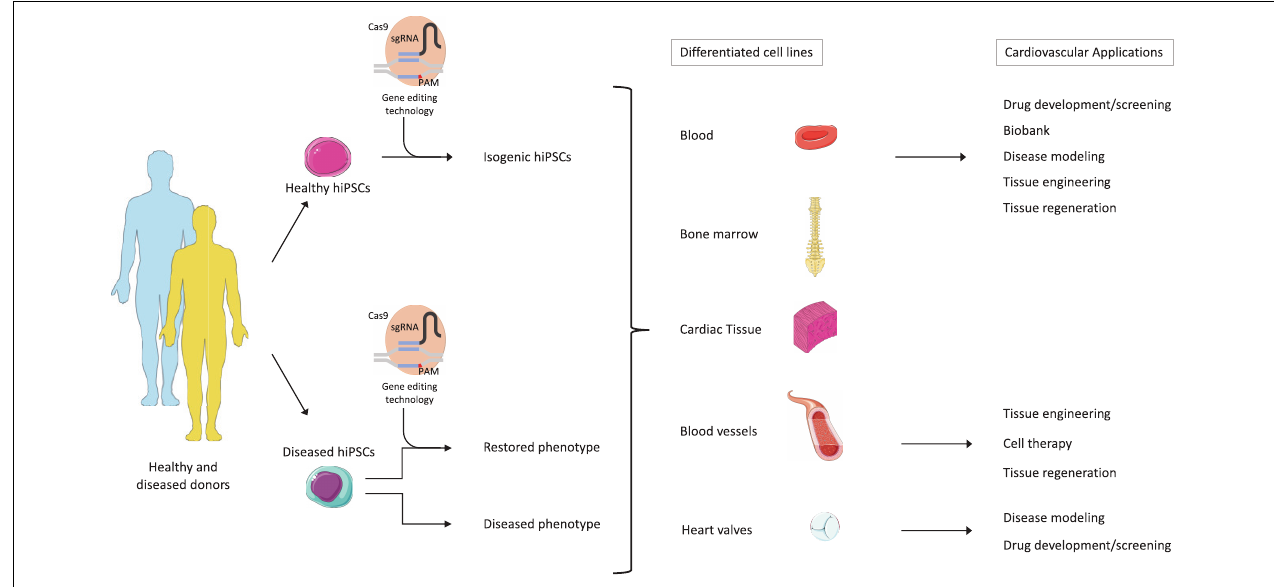
FIGURE 3 | Therapeutic potential of hiPSC technology combined to gene editing and tissue engineering. The figure describes the potential applications of hiPSCs and gene editing. First, hiPSCs would be generated from the reprogramming of patient-specific healthy or diseased somatic cells. Second, gene editing tools, such as CRISPR-Cas9, would then generate isogenic cell lines harboring specific genetic mutations in the healthy hiPSCs, but also correct disease-causing mutations in the patient populations. The generated hiPSCs could then be re-differentiated into various cell types and/or tissue. Finally, the differentiated isogenic hiPSCs could be implemented in drug development/screening processes, biobanking, disease modeling, and tissue engineering. On the other side, the differentiated diseased hiPSCs could be further employed for disease modeling and drug development/screening. When genetic mutations are corrected, then cell-based therapy and tissue regeneration purposes can be applied. Adapted from servier medical art, licensed under a Creative Commons Attribution 3.0 Unported License.